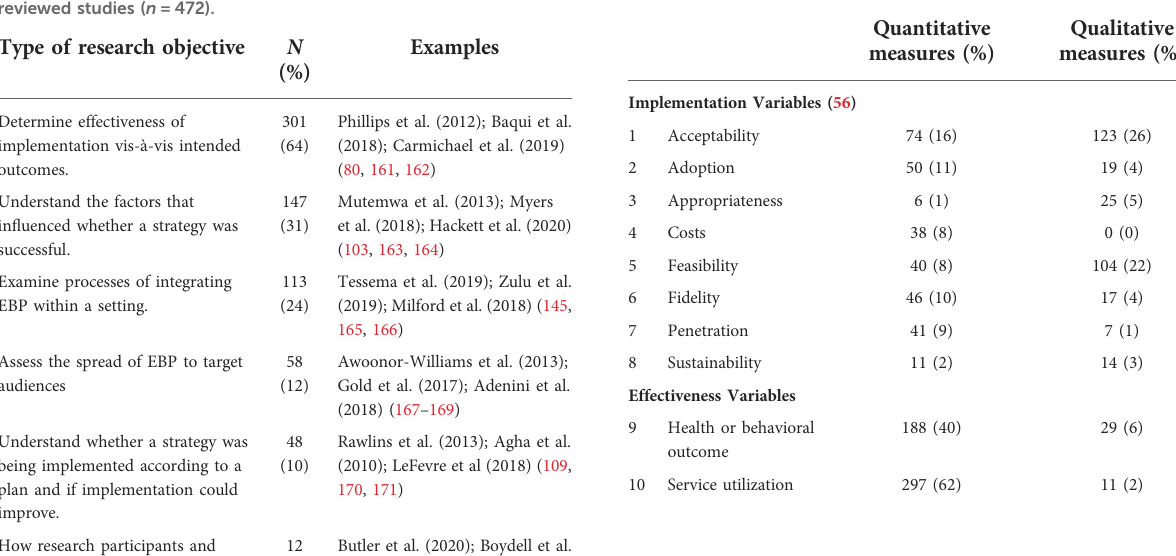
TABLE 4 Variables measured by fully reviewed